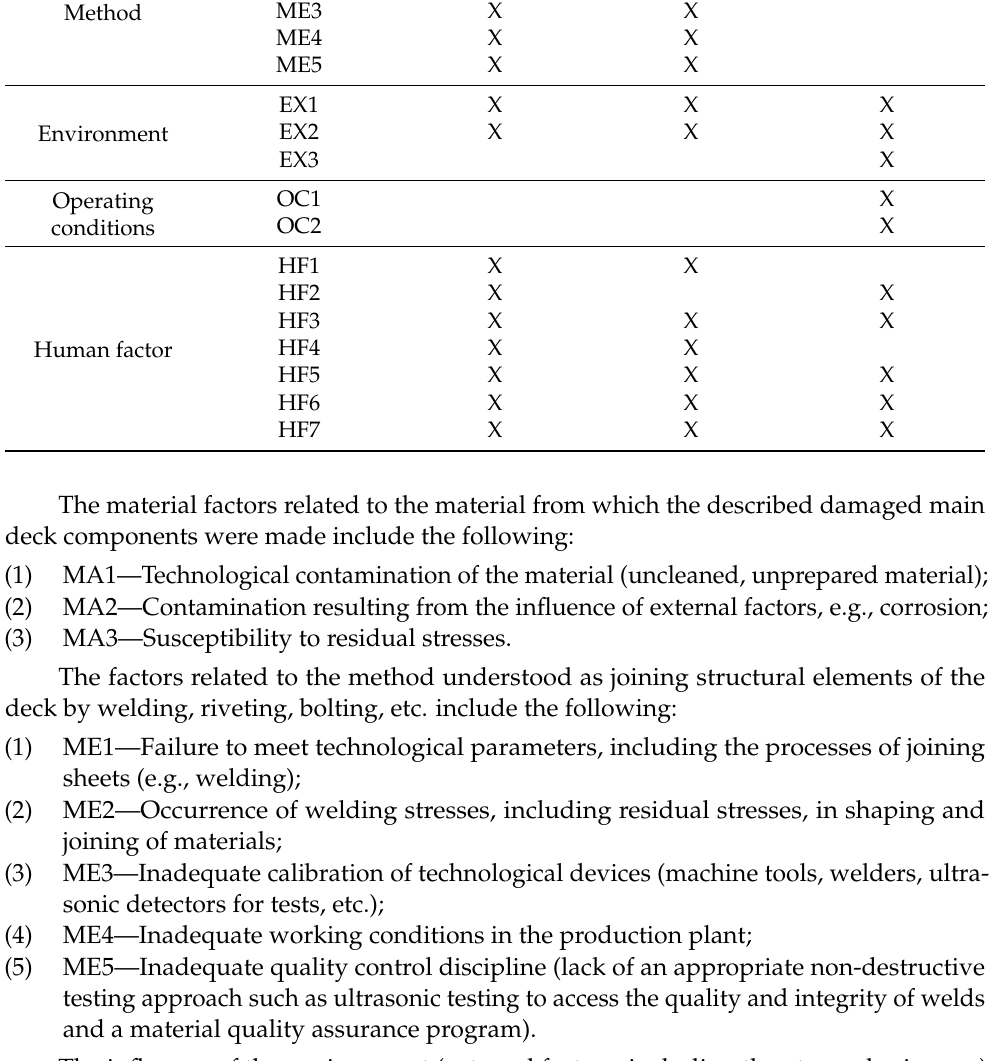
Fatigue Damage Factors Material Residual Cyclic Load Properties Stresses